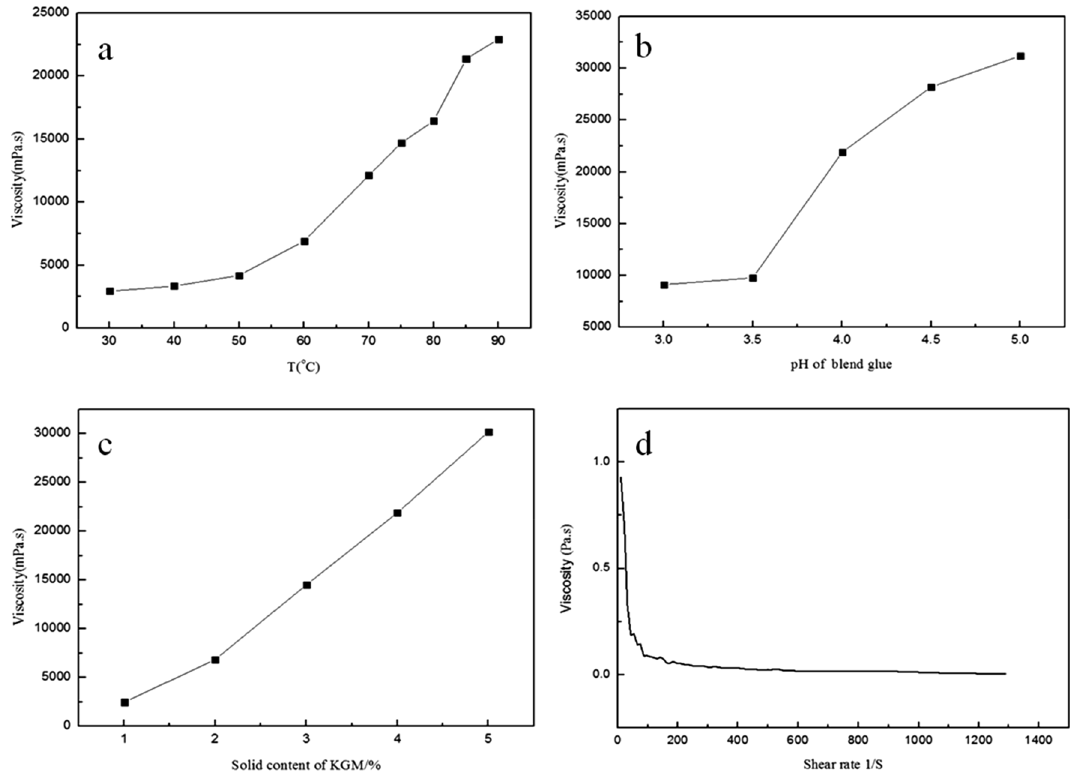
Figure 1. Relationship between blending factors and viscosity of ternary blend adhesive. ( a ) General conditions: Stirring time-40 min; Content of KGM, CA, PVA = 4.0%, 4.0%, 5.0%; pH of adhesive-4.5; ( b